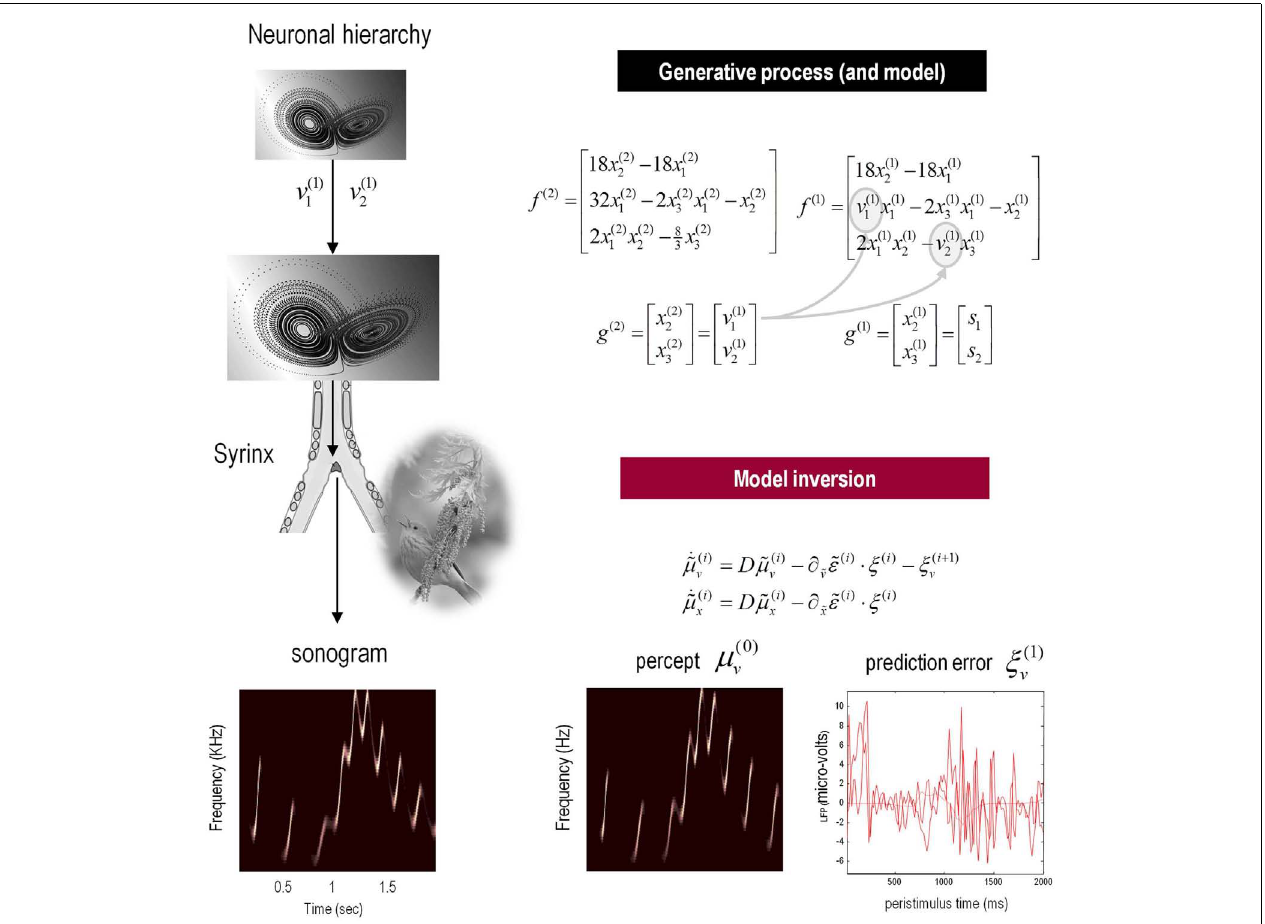
sonogram (lower left panel).The upper equations represent the hierarchical dynamic model in the form of Eq. 2; while the lower equations summarize the recognition or Bayesian filtering scheme in the form of (a simplified version of) Eq. 3.The lower right panels show the sensory predictions of this Bayesian filtering scheme in terms of the predicted sonogram based upon posterior expectations (left) and the precision-weighted prediction errors driving these expectations